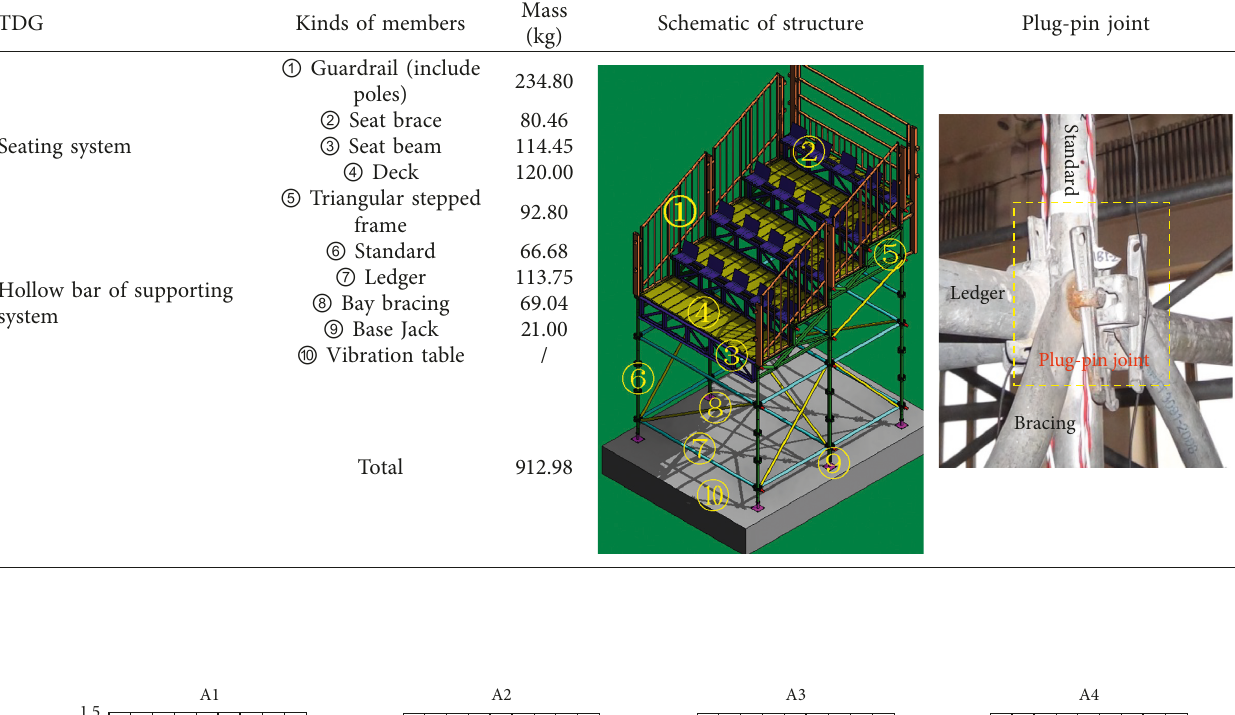
Table 7: Test structure.